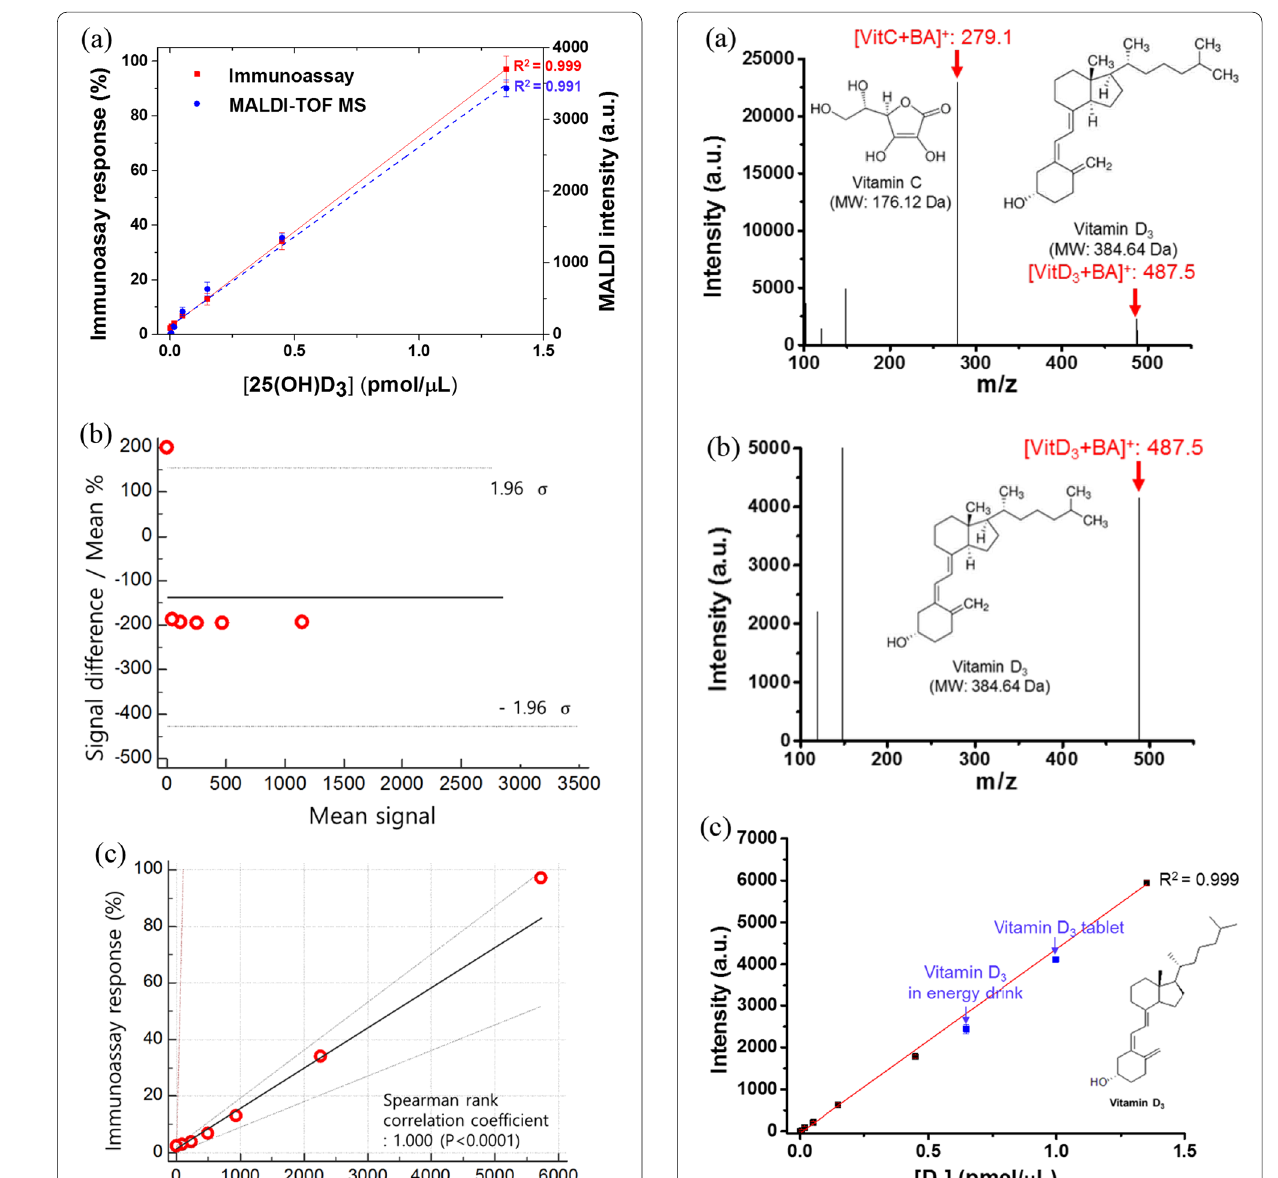
Fig. 7 Real sample analysis using MALDI‑TOF mass spectrometry based on parylene matrix chip. a Mass spectrum of energy drink. b Mass spectrum of vitamin D 3 tablet. c Comparison of the estimated concentration using standard curve for vitamin D